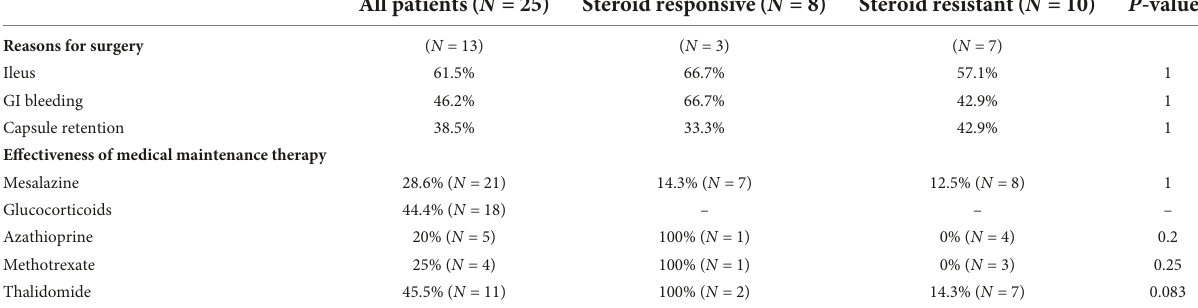
TABLE 2 The overall treatment efficacy in patients with CMUSE and differences between steroids-response subtypes. All patients ( N = 25) Steroid responsive ( N = 8) Steroid resistant ( N = 10) P